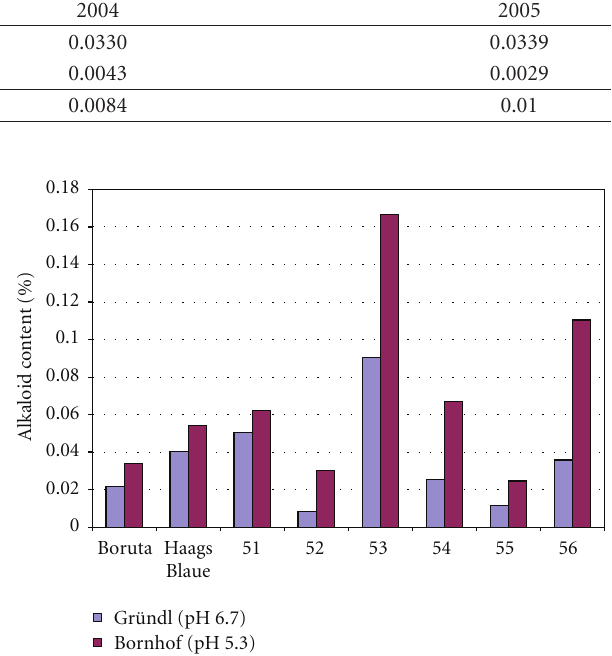
Figure 3: Influence of the soil pH on the main alkaloid content of Lupinus angustifolius cultivars and breeding lines